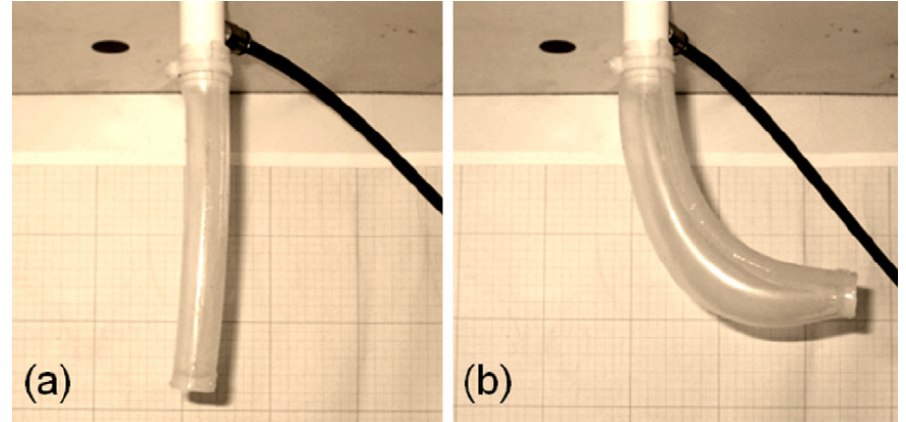
Figure 8. Bi-bellows bending actuator manufactured using silicone rubber ( a ) is unpressurized, ( b ) is pressurized [79]. (Copyright 2011, Elsevier.)